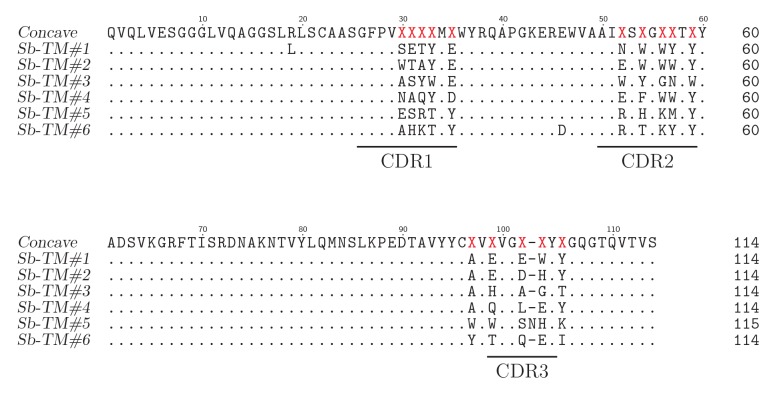
Sequence alignment of concave sybodies raised against TM287/288.